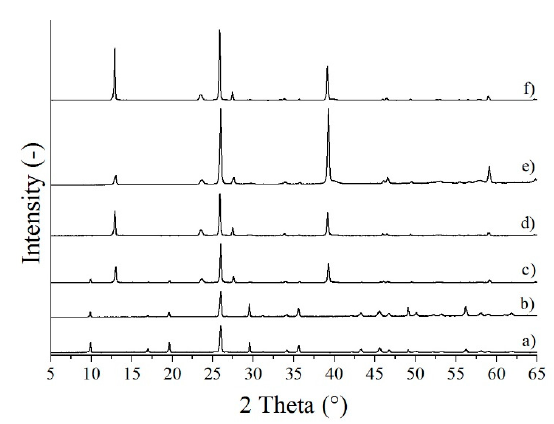
Figure 1. XRD patterns of the samples synthetized in the hydrothermal reaction of AHM and HNO 3 at different temperatures and durations, (a) MoO 3 -1 (90 °C, 3 h), (b) MoO 3 -2 (90 °C, 6 h), (c) MoO 3 -3 (210 °C, 3 h), (d) MoO 3 -4 (210 °C, 6 h), (e) MoO 3 -5 (240 °C, 3 h), (f) MoO 3 -6 (90 °C, 3 h).